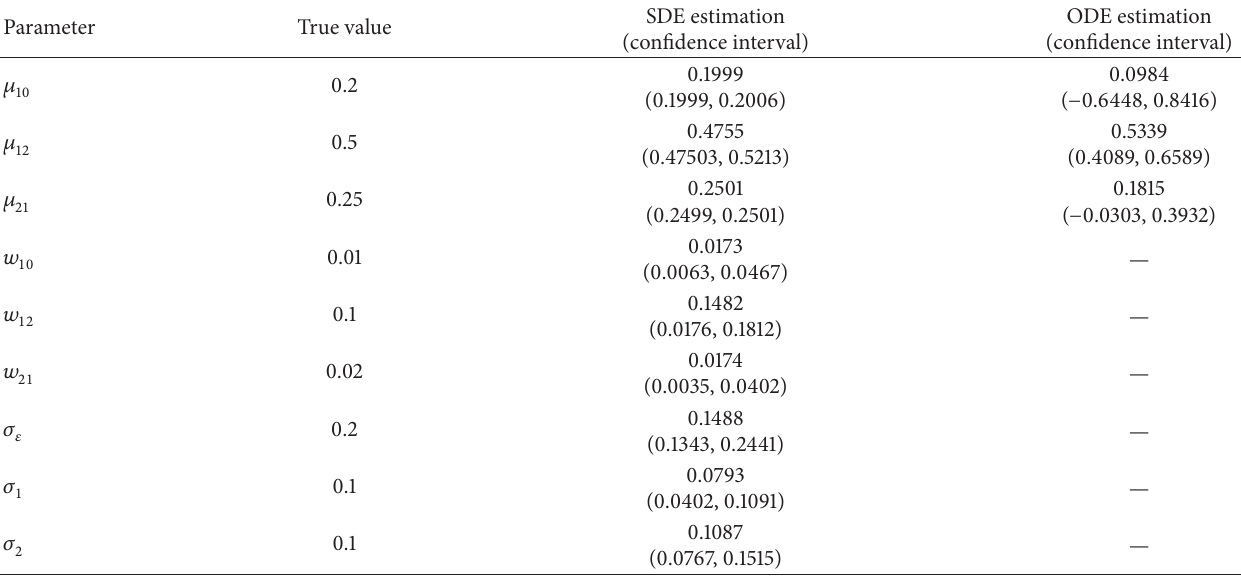
Table 1: Mean estimates and 95% credibility interval in brackets obtained from the SDE mixed-effects models and ODE models on 500 simulated datasets.